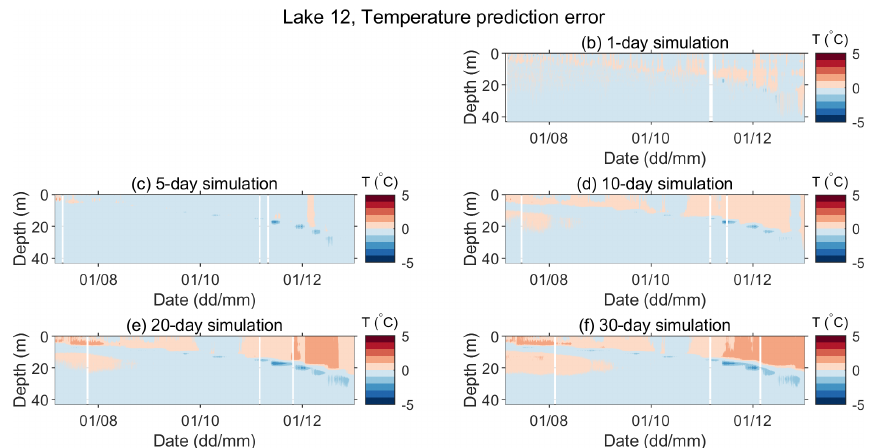
Figure A2. Error in the predicted water temperature ( P i − O i ) for Lake 12 for different simulation lengths in the period between 6 July and 31 December 2019. Panel (a) is omitted so that the panels’ positions for different simulation lengths correspond to those in Fig. 7.